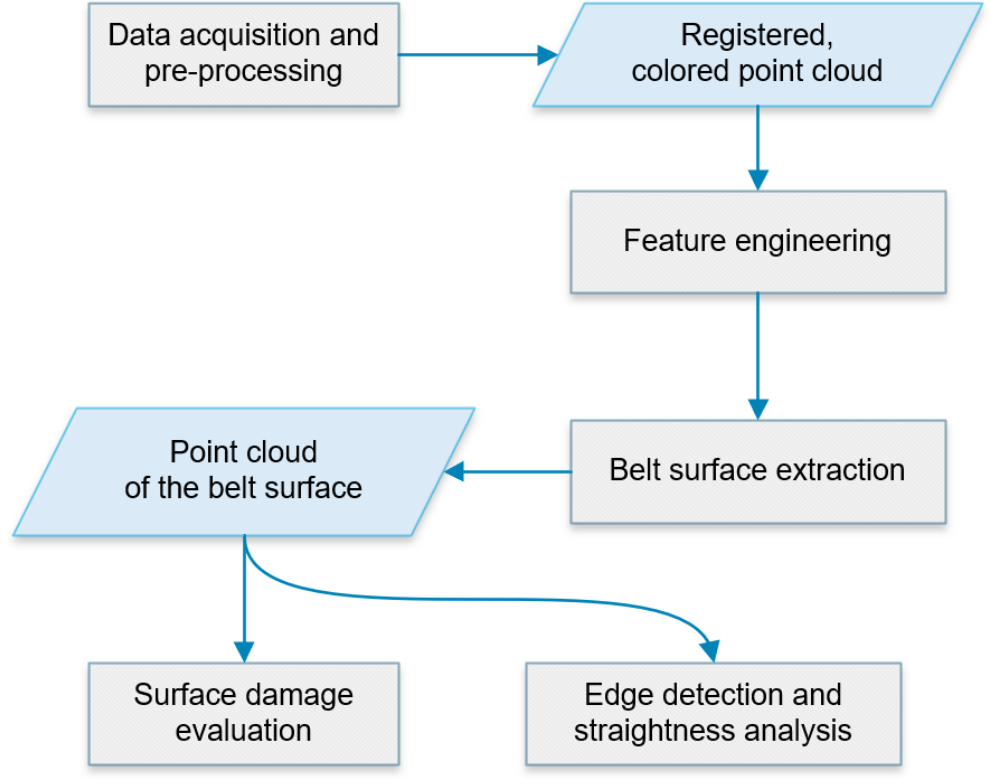
Figure 1. Data processing